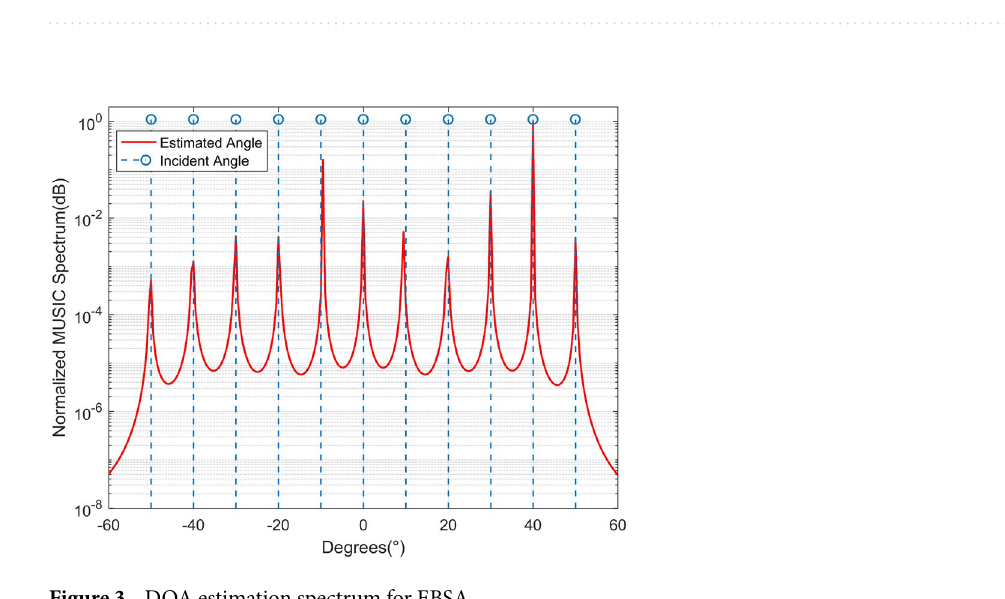
Figure 3. DOA estimation spectrum for